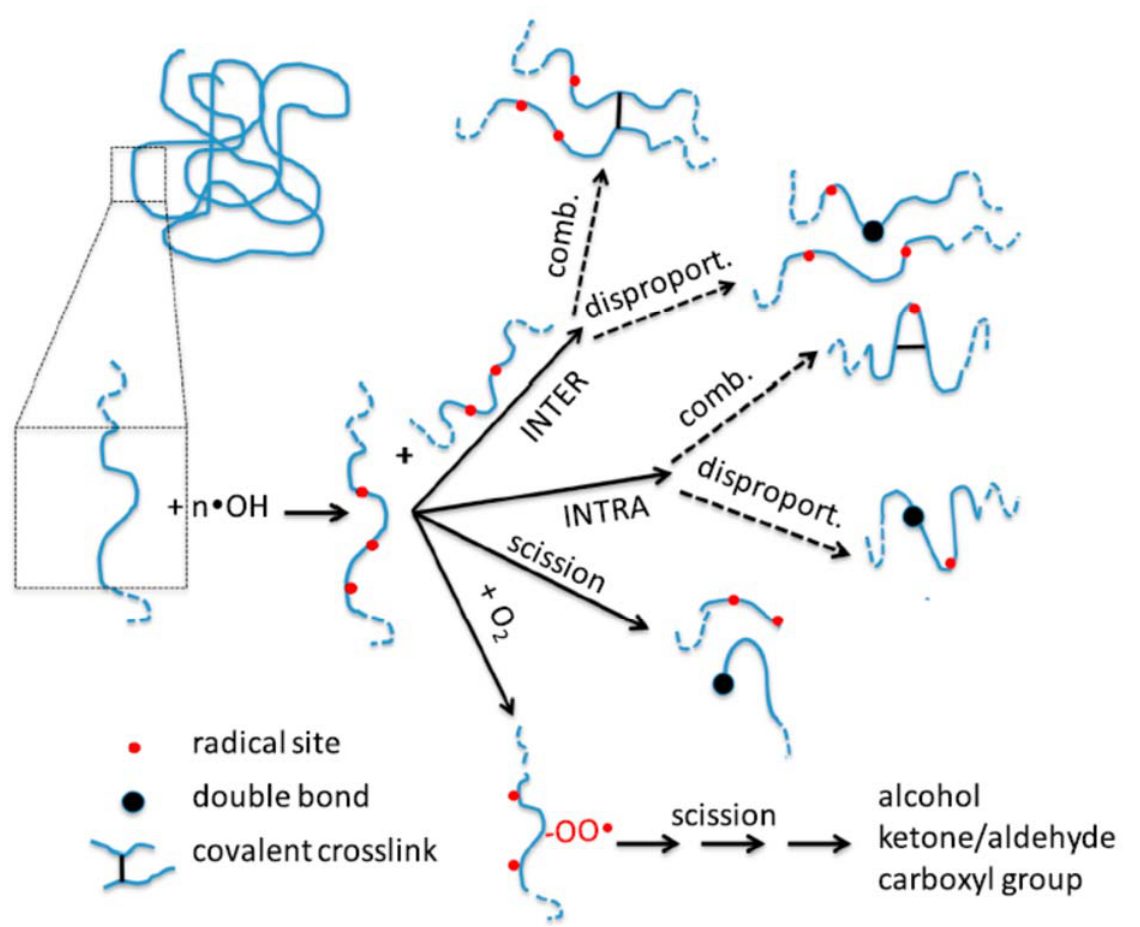
Figure 2. The fate of polymer-bound radicals generated by OH radical attack in aqueous systems. Reprinted with permission from Ref. [47]. Copyright 2021 Elsevier.